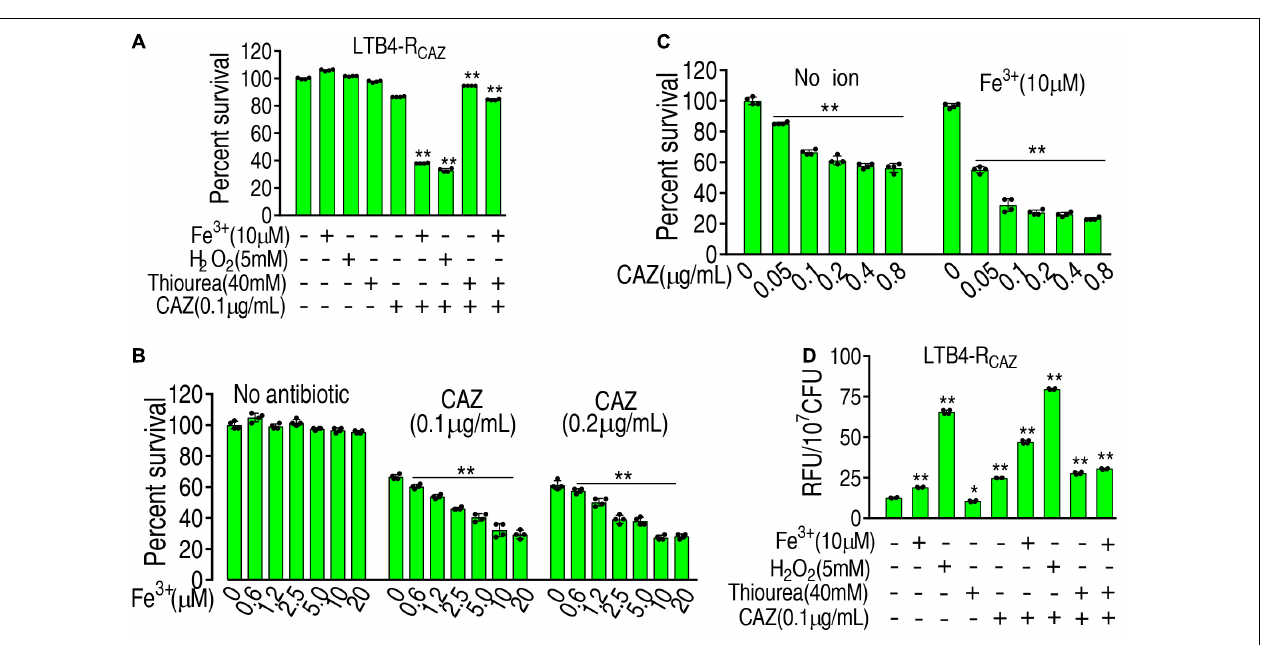
FIGURE 2 | The role of ROS in ceftazidime-mediated killing. (A) ROS was quantified in LTB4-R CAZ in the absence or presence of ceftazidime plus Fe 3 + , H 2 O 2 , or/and thiourea as indicated by fluorescence. (B) Percent survival of LTB4-R CAZ in the presence of ceftazidime and the indicated concentrations of Fe 3 + . (C) Percent survival of LTB4-R CAZ in the presence or absence of Fe 3 + plus the indicated concentrations of ceftazidime. (D) ROS level in the presence or absence of ROS promoter and inhibitor plus ceftazidime. Results are displayed as mean ± SEM, as determined by two-tailed Student’s t -test. Four biological repeats are carried out. * < 0.05 and ** <